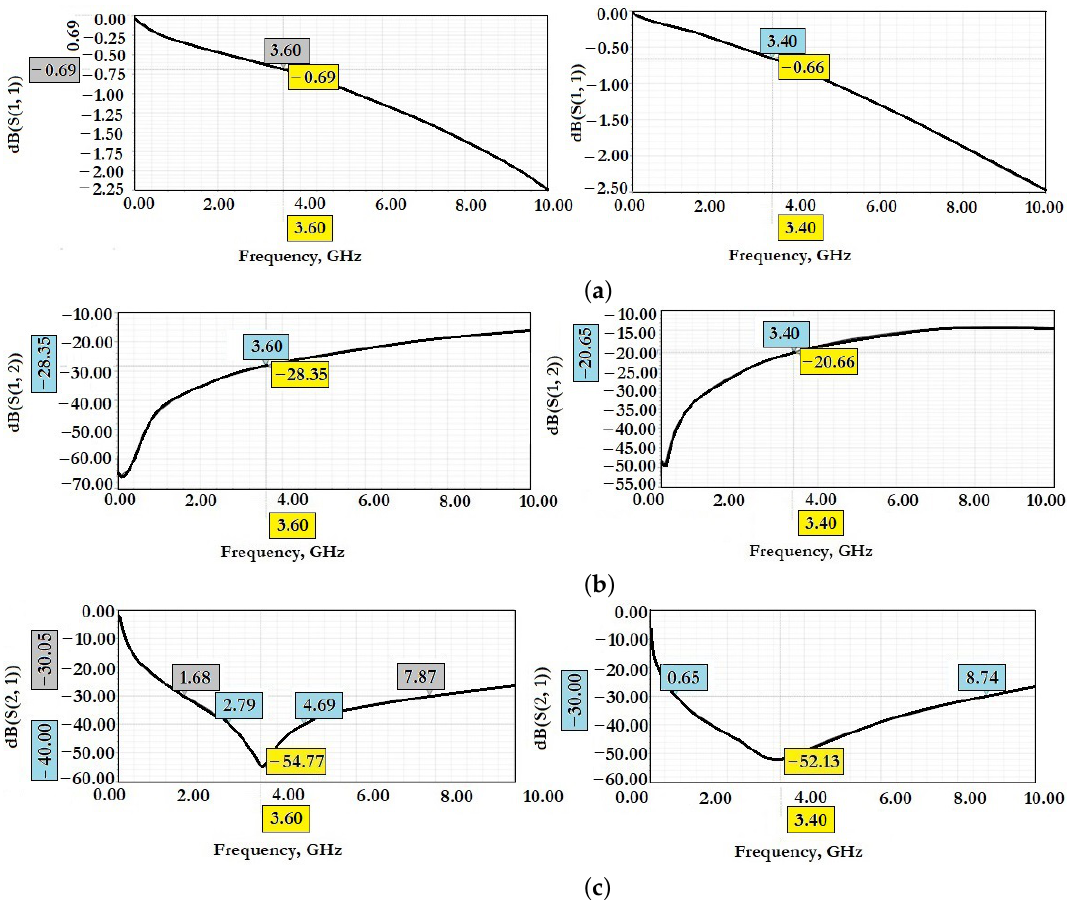
Figure 26. The results of the study of electromagnetic parameters of manufactured experimental samples of RF MEMS switch (A) and RF MEMS switch (B): ( a ) insertion loss in the open state; ( b ) reflection loss in the open state; ( c ) isolation in the closed